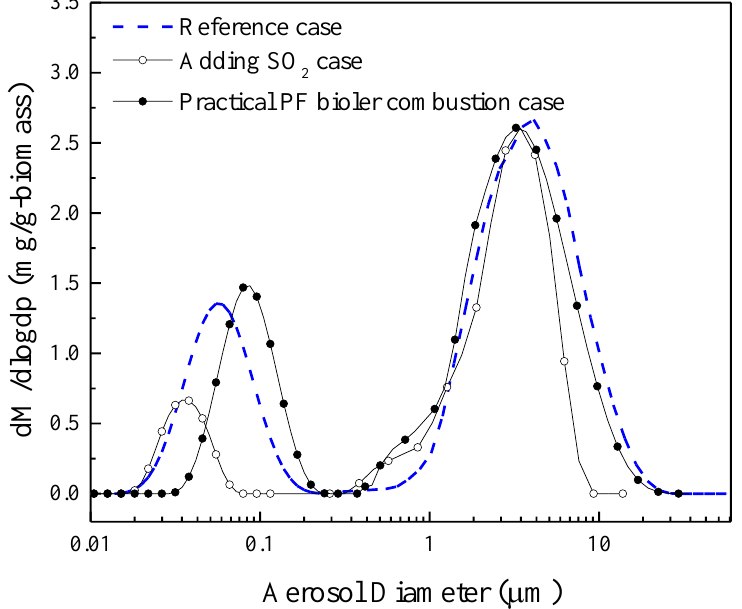
Figure 9. The comparison of calculated mass PSDs of PM 10 particles in the practical PF boiler combustion case, adding SO 2 case, and reference case. At 800–1100 ◦ C, KCl vapor is converted to K 2 SO 4 vapor through a global reaction [26,34]: KCl + H 2 O + SO 2 + 1/2O 2 → K 2 SO 4 + 2HCl. The pre-exponential factor of the rate constant of SO 2 oxidation, k SO = 69 s − 1 , and the activation energy, E a = 63 kJ/mol [34].